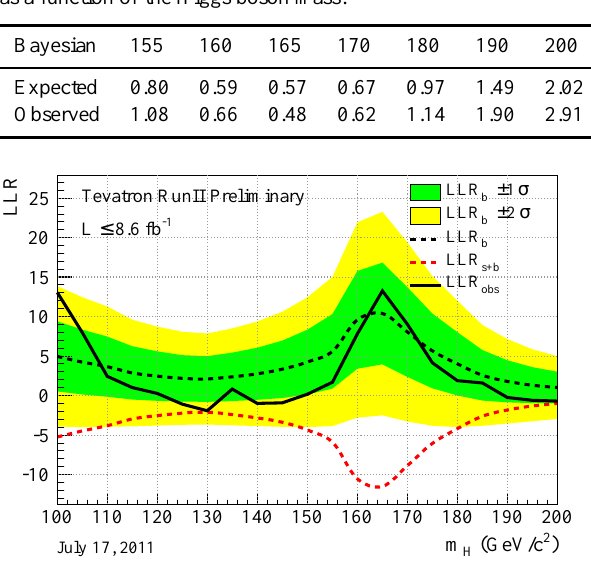
Table 2. Ratios of median expected and observed 95% C.L. limit to the SM cross section for the combined CDF and D0 analyses as a function of the Higgs boson mass.